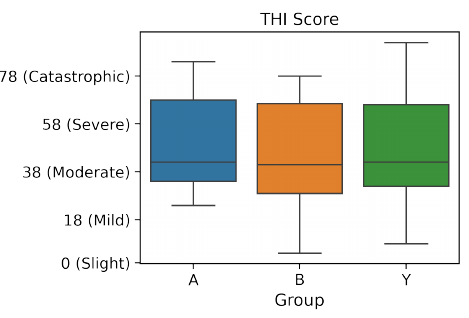
Figure 2. THI Scores at Baseline: Groups A, B and